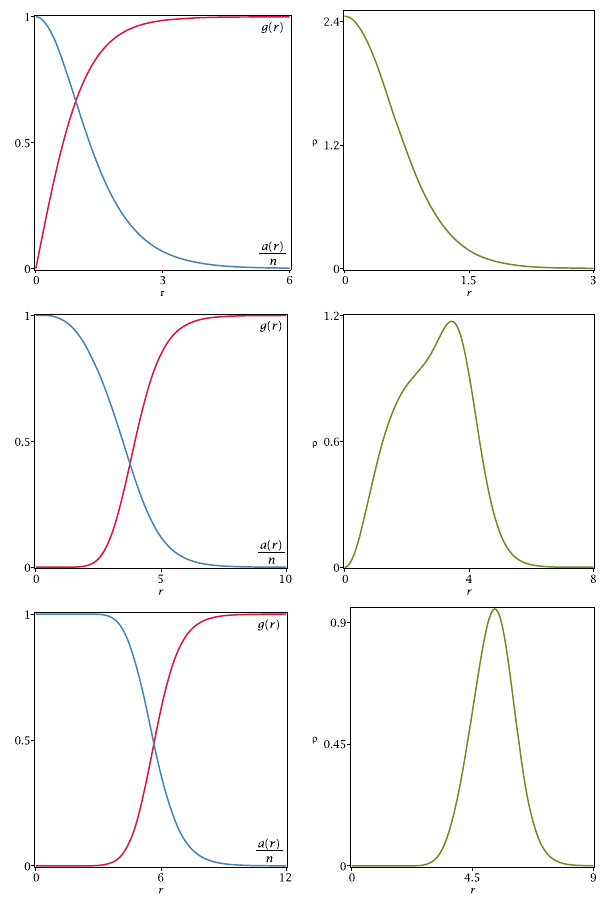
Fig. 1 Solutionsof(18)forgeneralizedpermeabilitiesoftheform(26). In the left, we depict the vortex solutions g 1 ( r ), g 2 ( r ), g 3 ( r ) (red lines, from top to bottom) and a 1 ( r )/ n 1 , a 2 ( r )/ n 2 , a 3 ( r )/ n 3 (blue lines, top to bottom). In the right, we depict the corresponding energy densities ρ ( r ), ρ ( r ), ρ ( r ) (green lines), from top to bottom. Here, n 1 2 3 n 2 = n 3 = 10